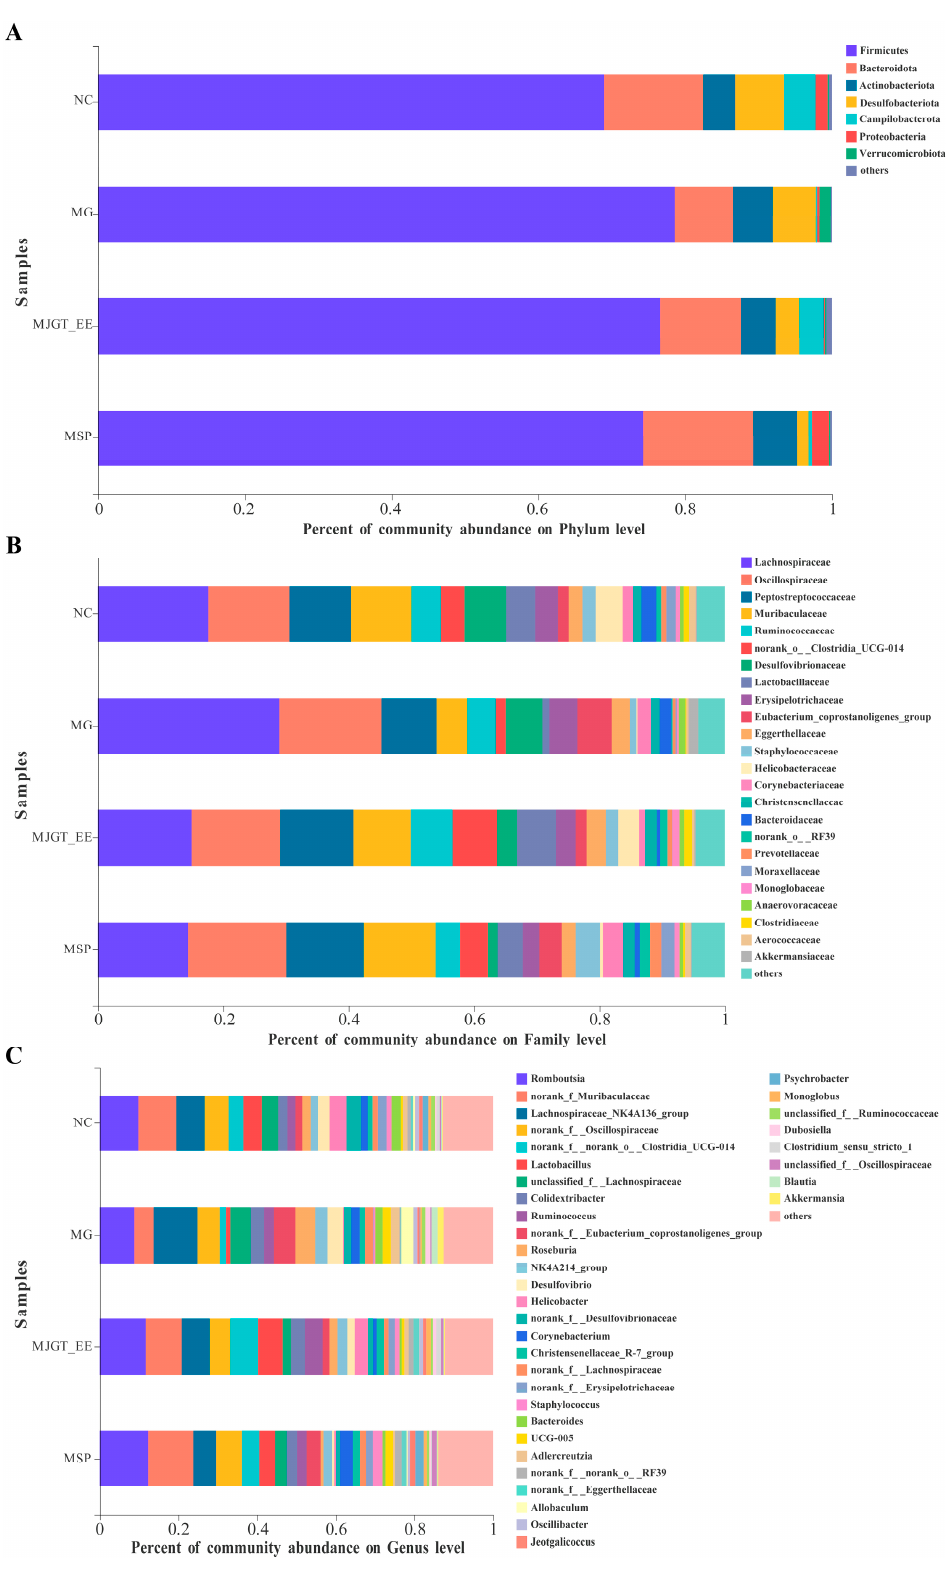
Figure 7. The variations in intestinal flora composition are displayed the phylum ( A ) and family ( B ) and genus level ( C ), respectively. ( n = 4 for each group). NC: negative control group; MG: model group, MSP: mosapride group, MJGT_EE: Mao Jian Green Tea ethanol extract